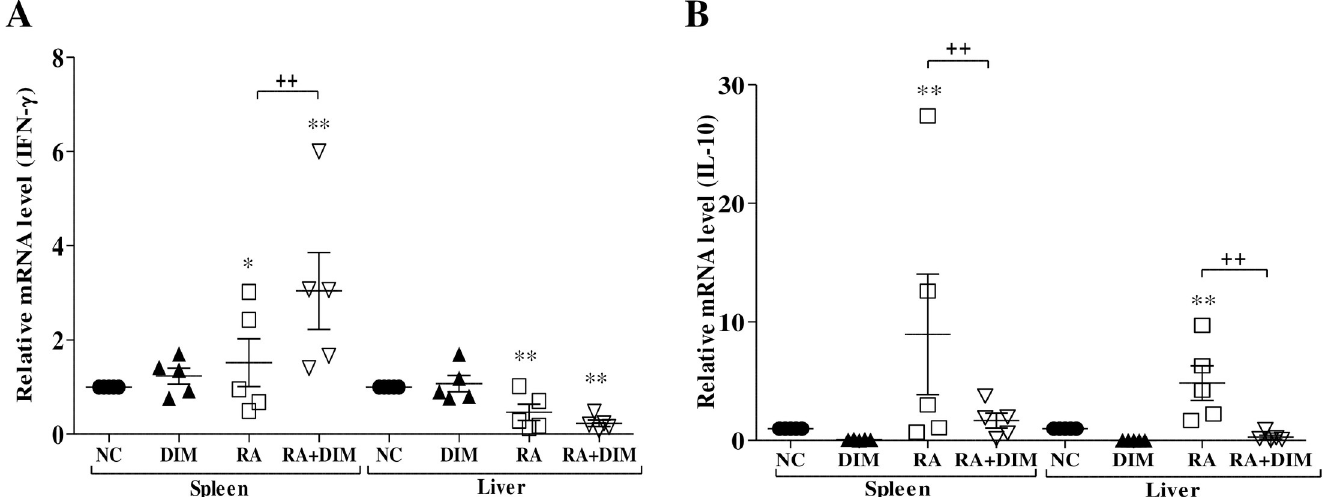
Fig 4. Effect of DIM on IFN- γ and IL-10 expression in R . anatipestifer– infected ducks. Two-week-old ducks were inoculated intramuscularly with 5 × 10 7 CFU of R . anatipestifer serotype 7 and treated orally with DIM (200 mg/kg/day) by gavage daily from 1 day prior to infection throughout the experimental period. Ducks (n = 5/group) were sacrificed on day 4 after infection. The spleen and liver were aseptically removed, homogenized using a grinder, and subjected to qRT-PCR. The levels of IFN- γ (A) and IL-10 (B) mRNA were normalized to that of β -actin and calibrated using the expression levels of uninfected/untreated healthy birds (NC). Data are expressed as the mean ± SE of five birds and one representative of two independent experiments. � P < 0.05 and �� P < 0.01 compared to NC. ++ P < 0.01 for comparison of the infected/untreated group with the infected/treated group. RA, R . anatipestifer ; DIM, 3,3’-diindolylmethane.